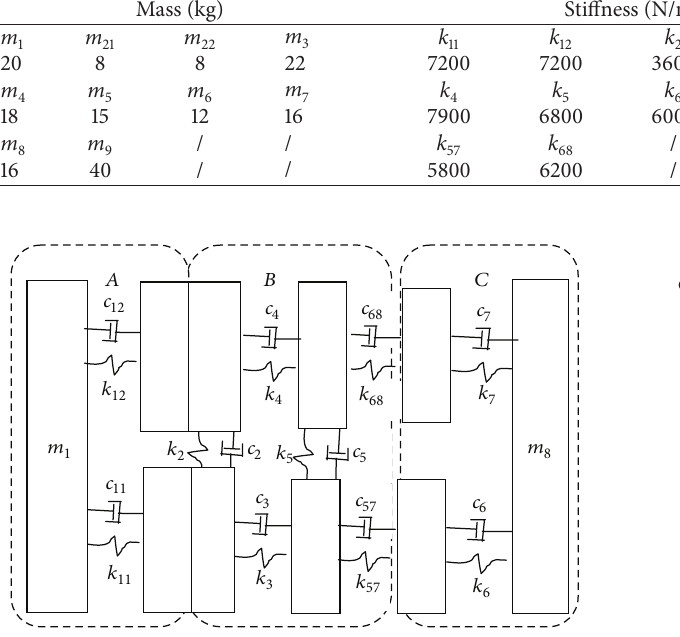
Figure 4: A lumped mass-spring-damper